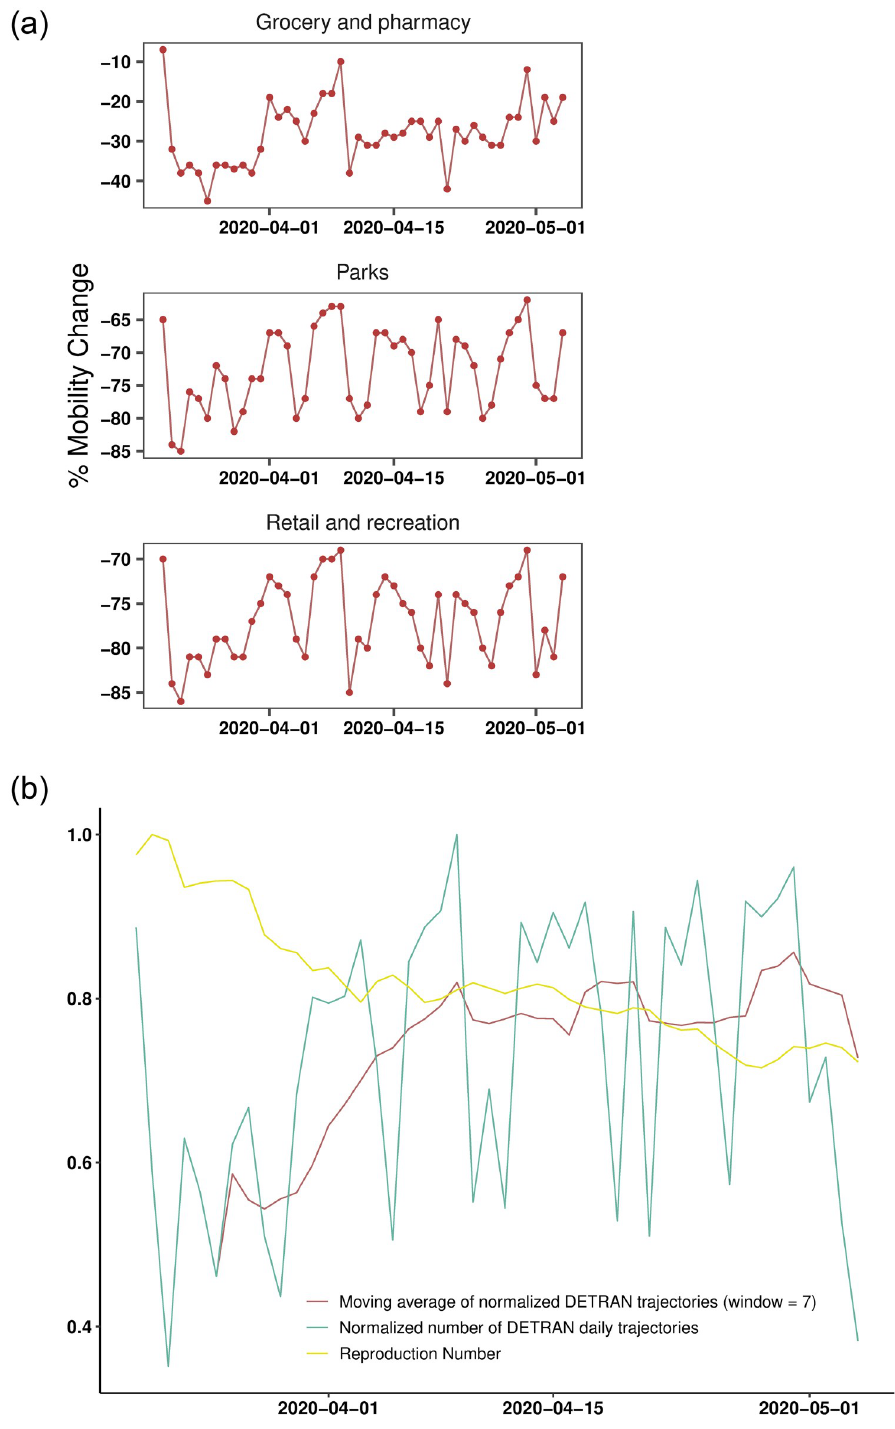
Fig 10. Aggregate flow of vehicles and the reproduction number between the dates 03/20/2020 and 05/04/2020. Plots in the left show mobility indexes extracted from the Google report, and plots in the right depict the R ( t ) estimated from DETRAN-CE’s data. We can see similarities between trends in DETRAN-CE’s data and the mobility indexes extracted from the Google report. The highest cross-correlation results are in places labeled as retail and recreation, grocery and pharmacy, and